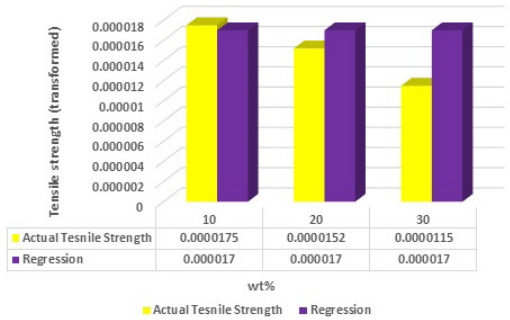
Figure 10. A comparison between the regression equation and the actual value of the tensile strength of treated sisal-PP composite.